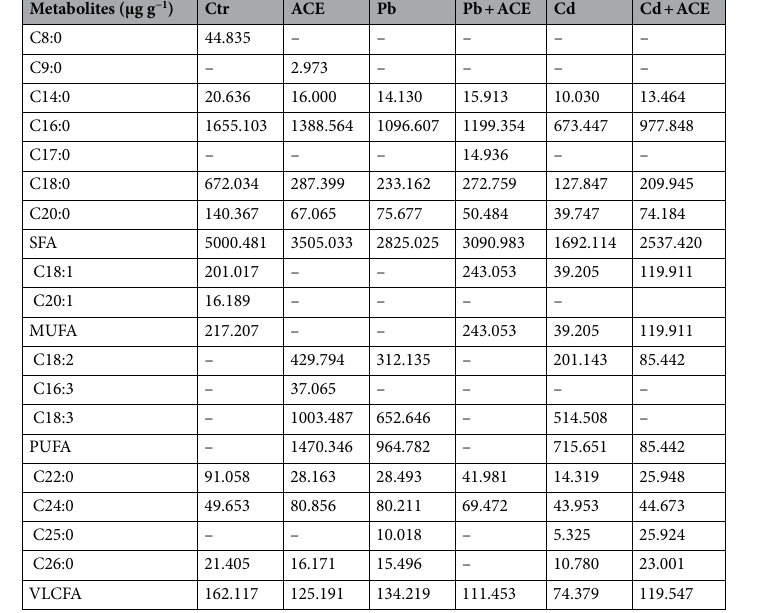
Table 1. Effect of ACE on FAME changes under Pb and Cd stress.